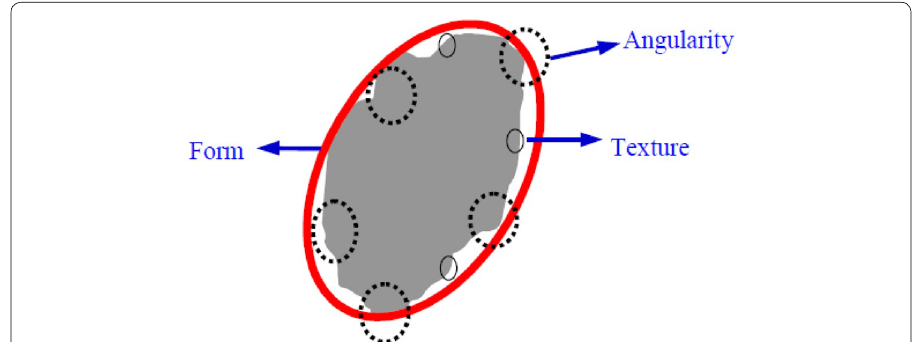
Fig. 1 Components of aggregate shape properties: form, angularity and texture (after Masad